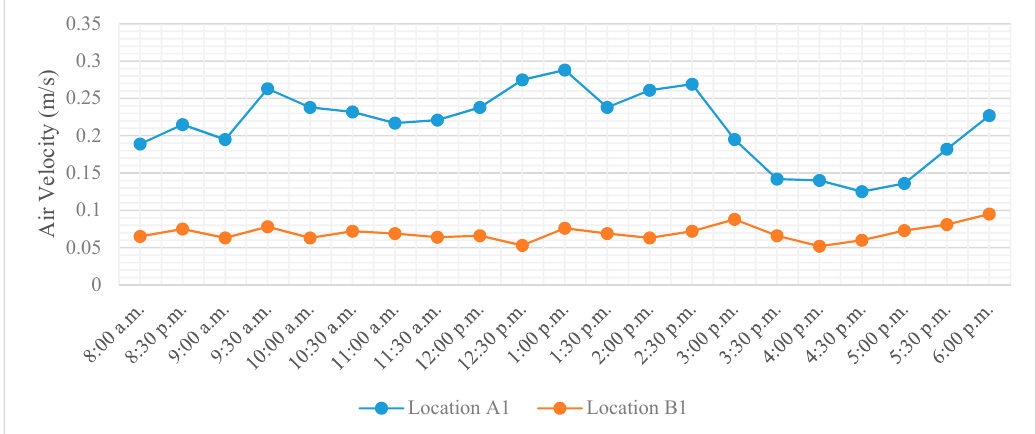
Figure 14. Indoor air velocity in the lobby of Building A (Location A1) and Building B (Location B1).